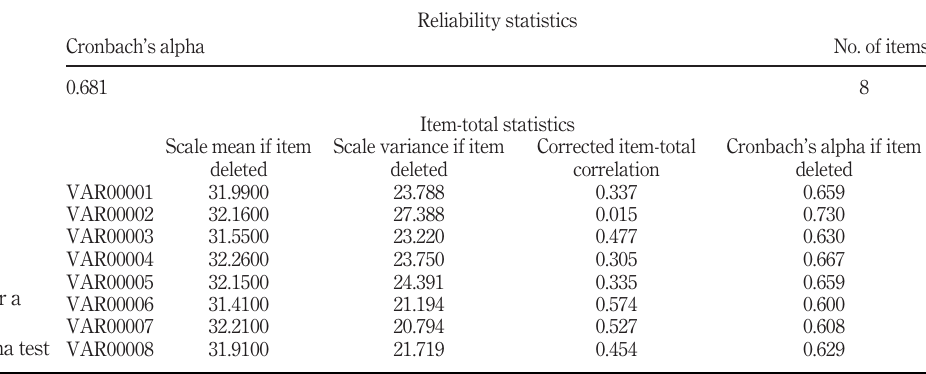
Table VII. Output SPSS for a decision on